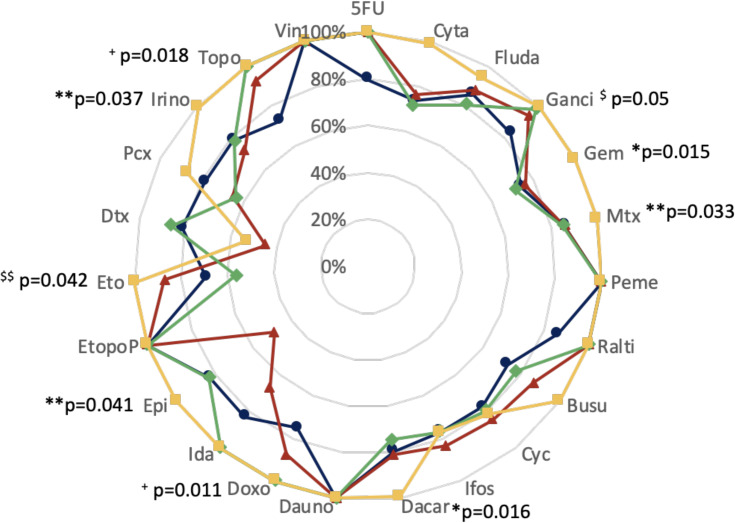
Comparison of decontamination efficiency per contaminant of four decontamination or deactivation solutions after standard single motion.Values represented are median Effq for each drug (n = 6). 5FU: 5-fluorouracil; Cyta: cytarabine; Fluda: fludarabine; Ganci: ganciclovir; Gem: gemcitabine; Mtx: methotrexate; Peme: pemetrexed; Ralti: raltitrexed; Busu: busulfan; Cyc: cyclophosphamide; Ifos: ifosphamide; Dacar: dacarbazine; Dauno: daunorubicin; Doxo: doxorubicin; Ida: idarubicin; Epi: epirubicin; EtopoP: etoposide phosphate; Eto: etoposide; Dtx: docetaxel; Pcx: paclitaxel; Irino: irinotecan; Topo: topotecan; Vin: vincristine. Blue line/circles: 70% isopropanol; red line/triangles: admixture of ethanol-hydrogen peroxide (91.6–50.0 mg/g); green line/diamonds: admixture of 10−2 M sodium dodecyl sulfate/isopropanol (80/20) and yellow line/squares: sodium hypochlorite. * Significant difference for solution 4 over other solutions; ** Significant difference between solutions 4 and 2; $ significant difference between solutions 4 and 1 and between $ $ solutions 4 and 3. + significant difference for both solutions 3 and 4 compared to others.